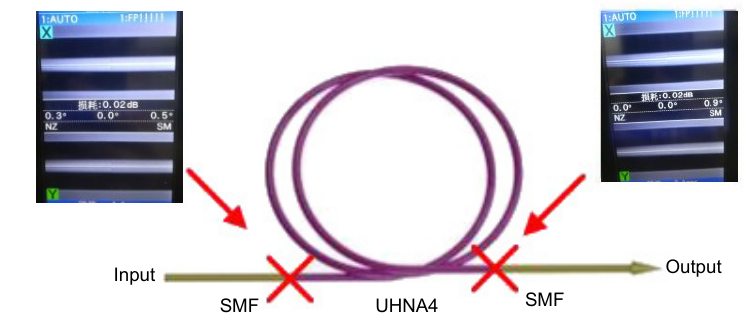
Fig 5 | Schematic diagram of UHNA4 fiber loss Table 2 | Testing results of insertion loss.